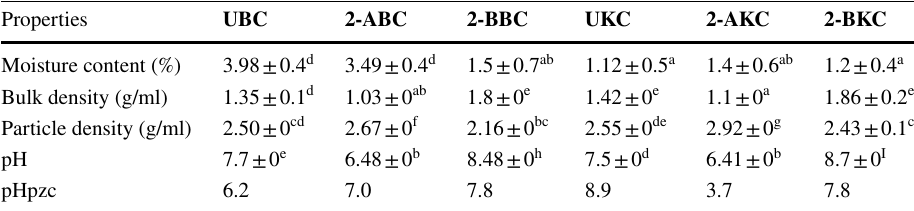
properties of various adsorbents with Duncan multiple range test